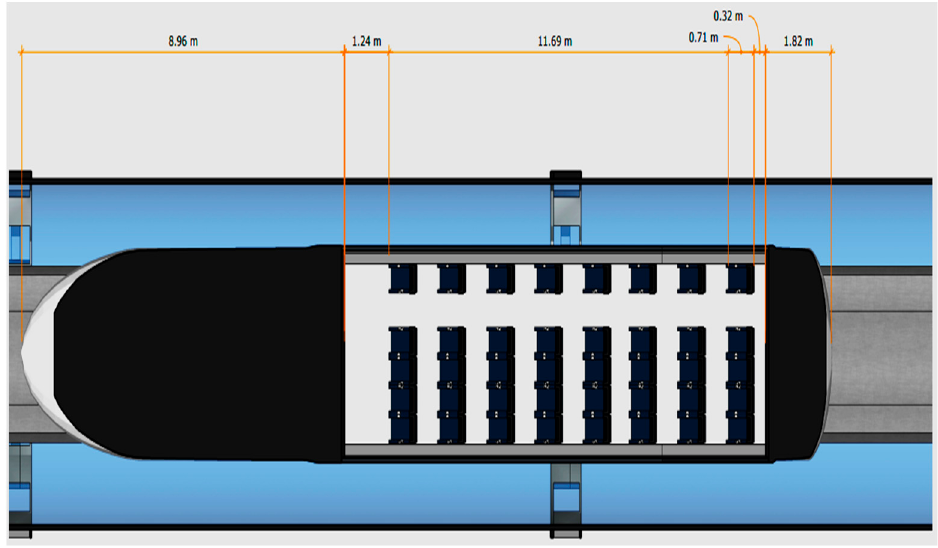
Figure 2. Medium-capacity capsule.